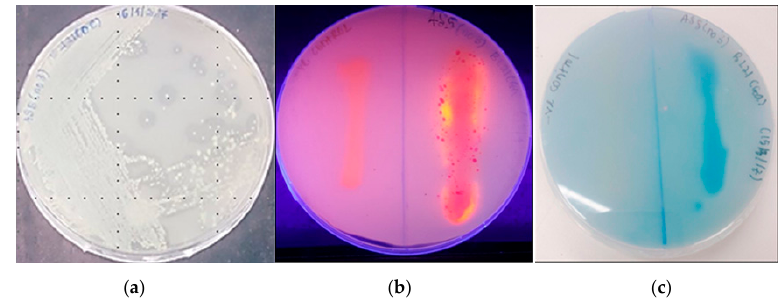
Figure 1. Qualitative analysis of recombinant LSK25 lipase on various agar plates. ( a ) clearing zone on tributyrin agar; ( b ) lipolytic activity on Rhodamine B, with substrate hydrolysis leading to the formation of an orange fluorescent halo upon exposure to UV radiation; and ( c ) lipolytic activity confirmation due to dye indicators on triolein agar. Negative control is indicated in the qualitative plates of b and c . Int. J. Mol. Sci. 2019 , 20 FOR PEER REVIEW